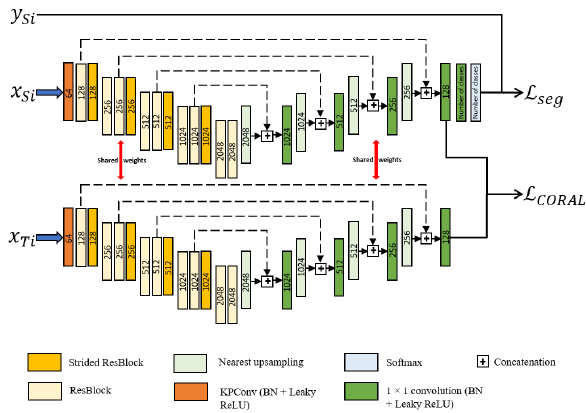
Figure 1. Illustration of the network